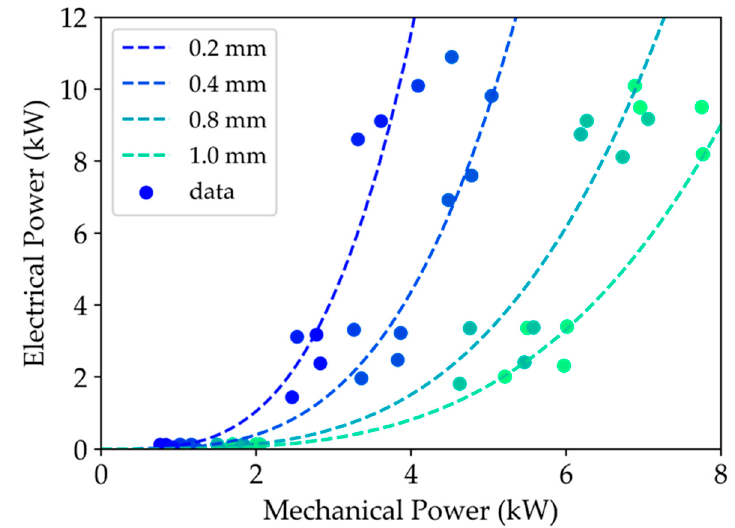
Figure 9. Model correlation between the mechanical power, calculated based on the recorded forces, and the electrical power obtained on the ServoGuide system as a function of the a p .